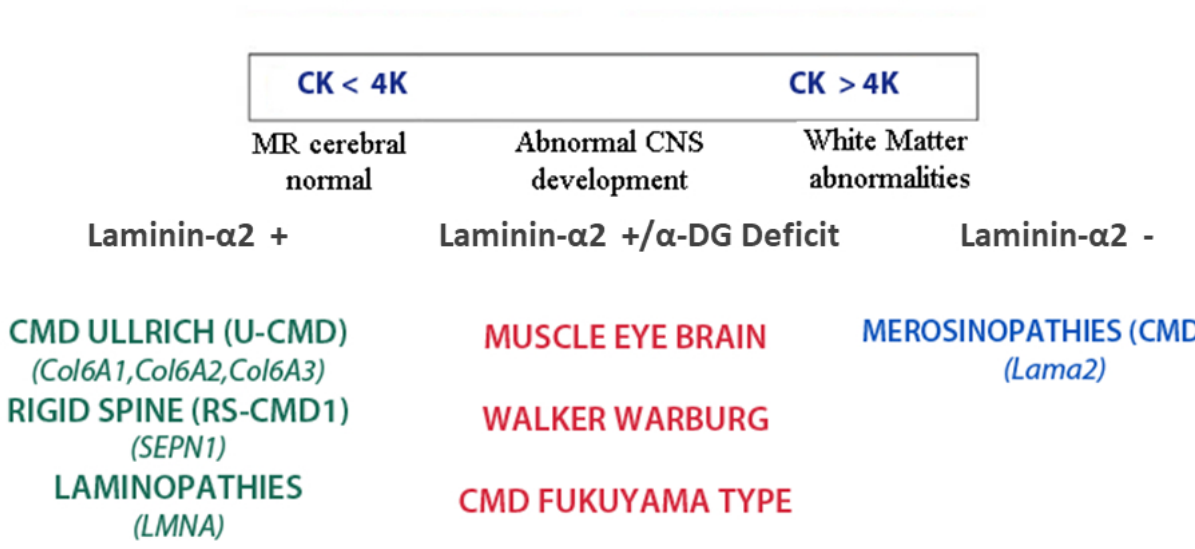
Figure 1. Classification of Congenital Muscular Dystrophies. Adapted from Quijano et al